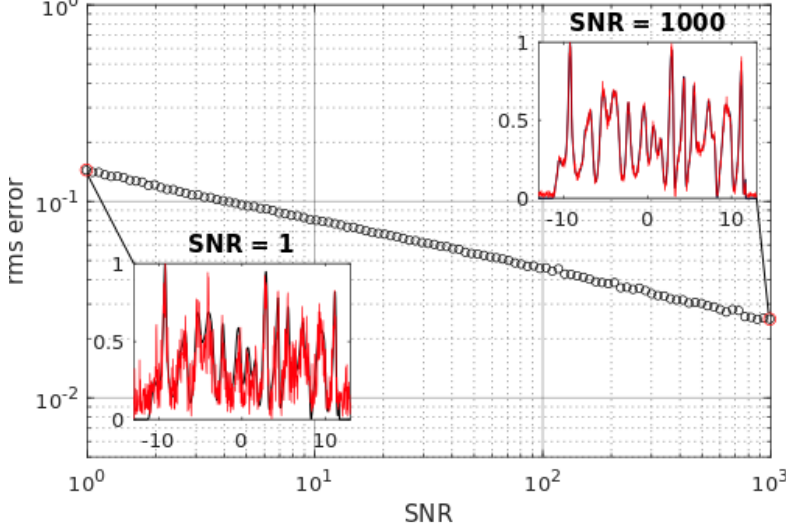
Figure 4. Ptychographic reconstruction of a simulated SASE waveform for a signal-to-noise ratio, increasing from 1 to 1000. The insets show the original (black curve) and the reconstructed (red curve) X-ray waveforms as functions of time for the two extreme cases, i.e., SNR = 1 and SNR =